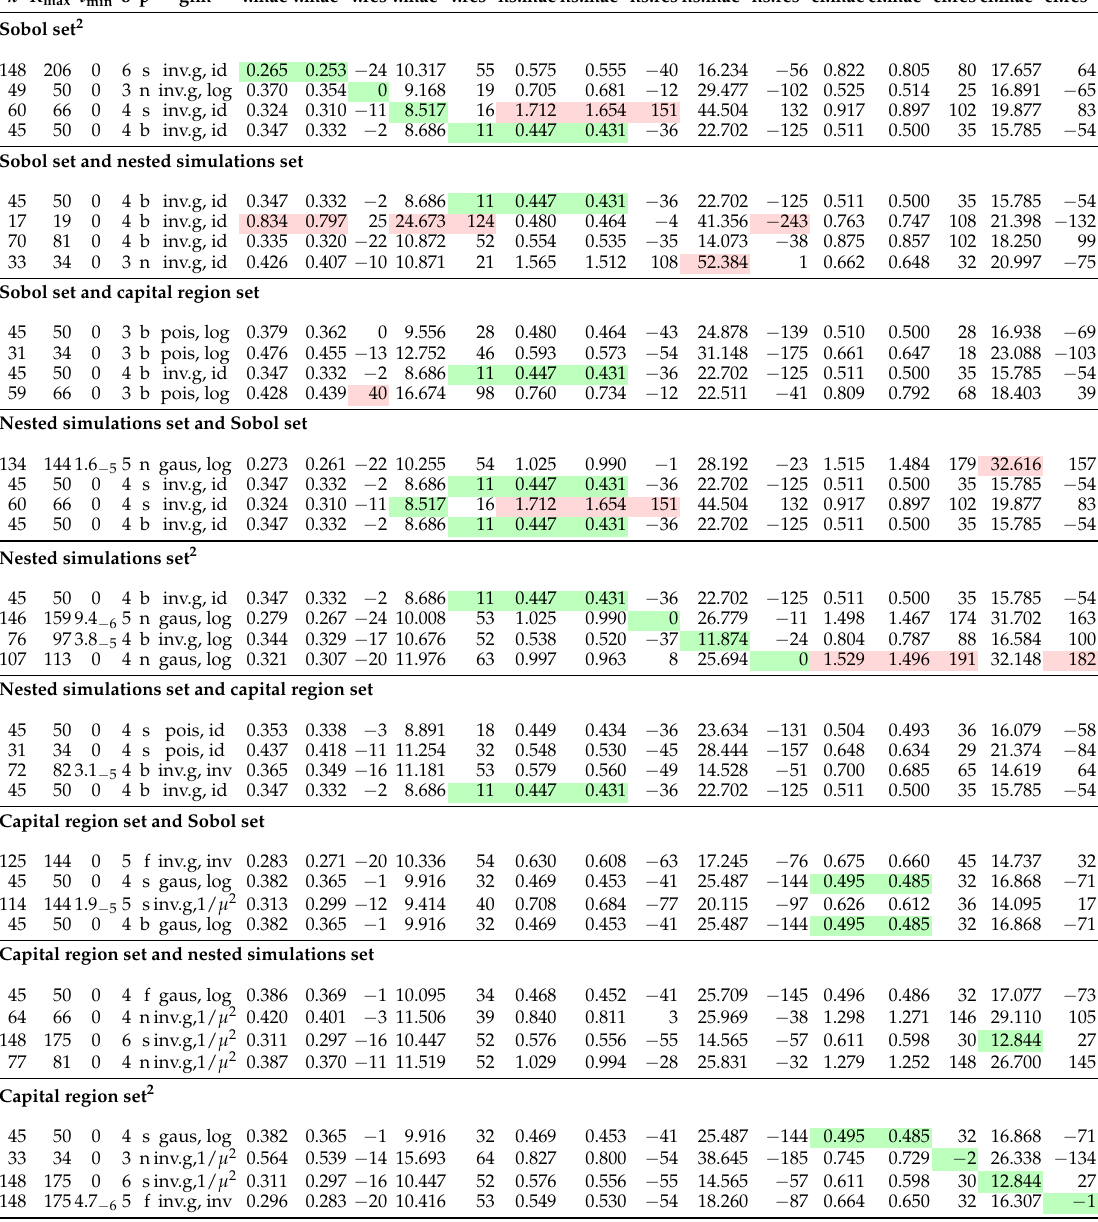
Table A31. Settings and out-of-sample validation figures of best performing multivariate adaptive regression splines (MARS) models derived in a two-step approach sorted by first and second step validation sets. Highlighted in green and red respectively the best and worst validation